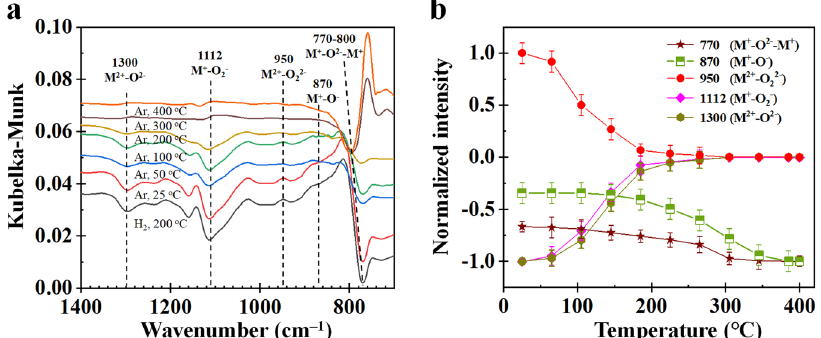
Fig. 4 Experimental results of the regeneration of H 2 -reduced β -MnO 2 in Ar at various temperatures. a DRIFTS spectra. b normalized intensities where the error bars are the standard deviations obtained by measuring the peak heights more than three times.